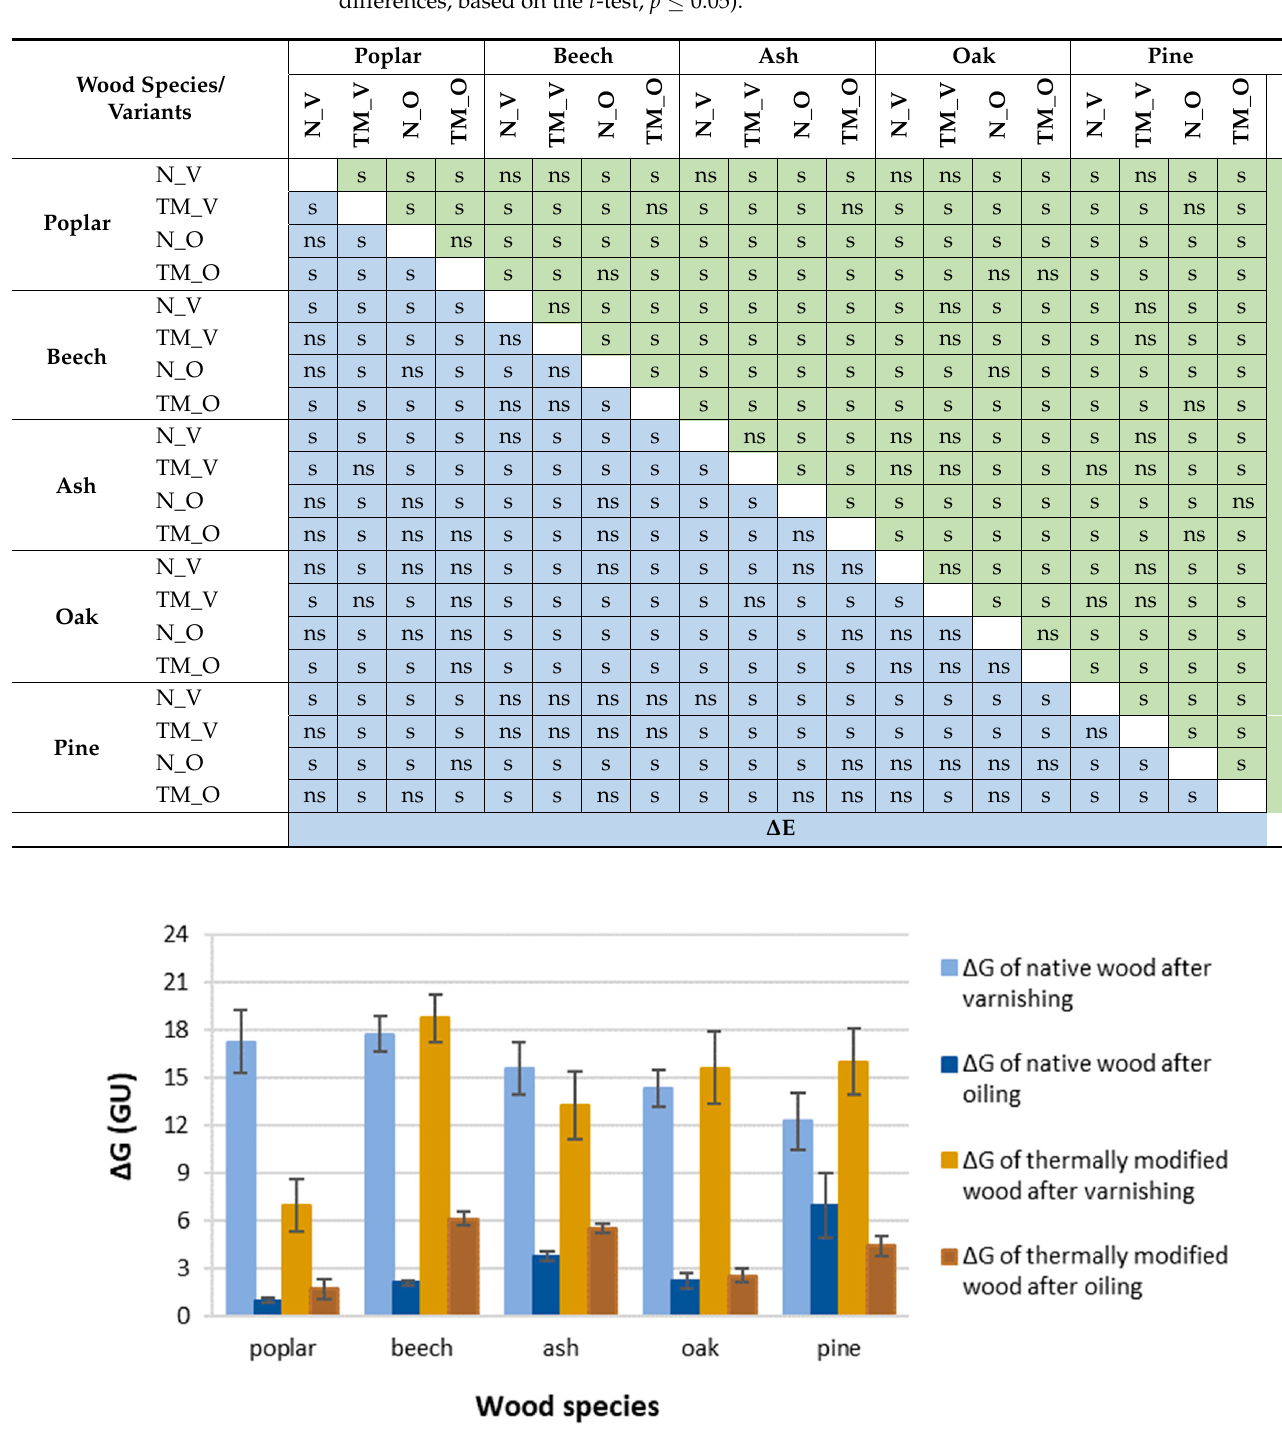
Figure 6. The gloss changes Δ G of varnished, oiled native and thermally modified wood.